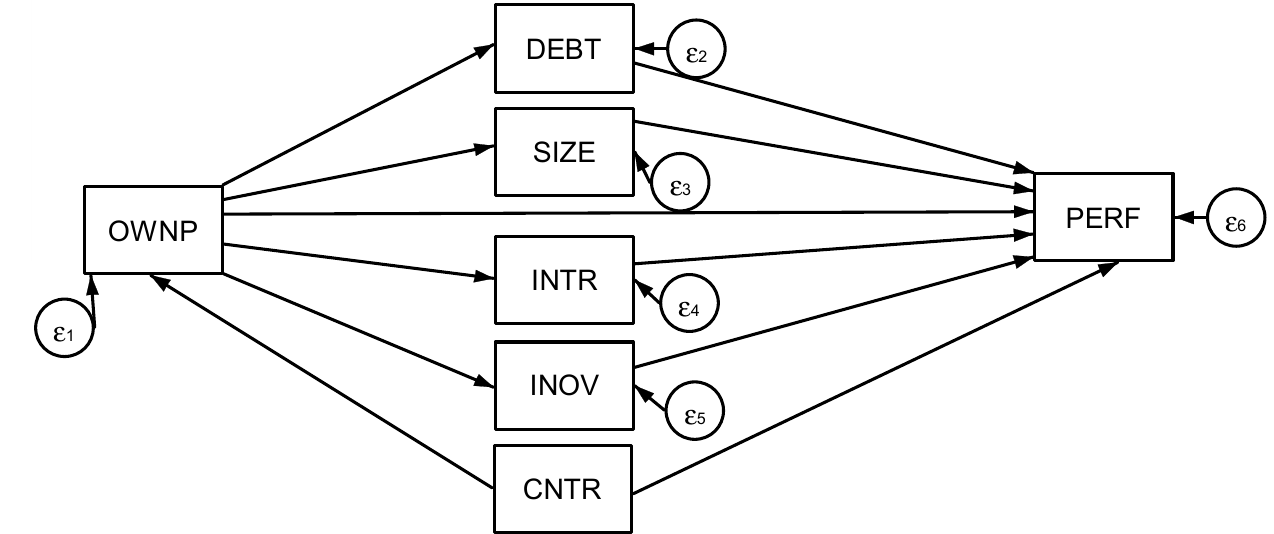
Figure 1. The structure of the SEM approach . Source: Own elaboration.